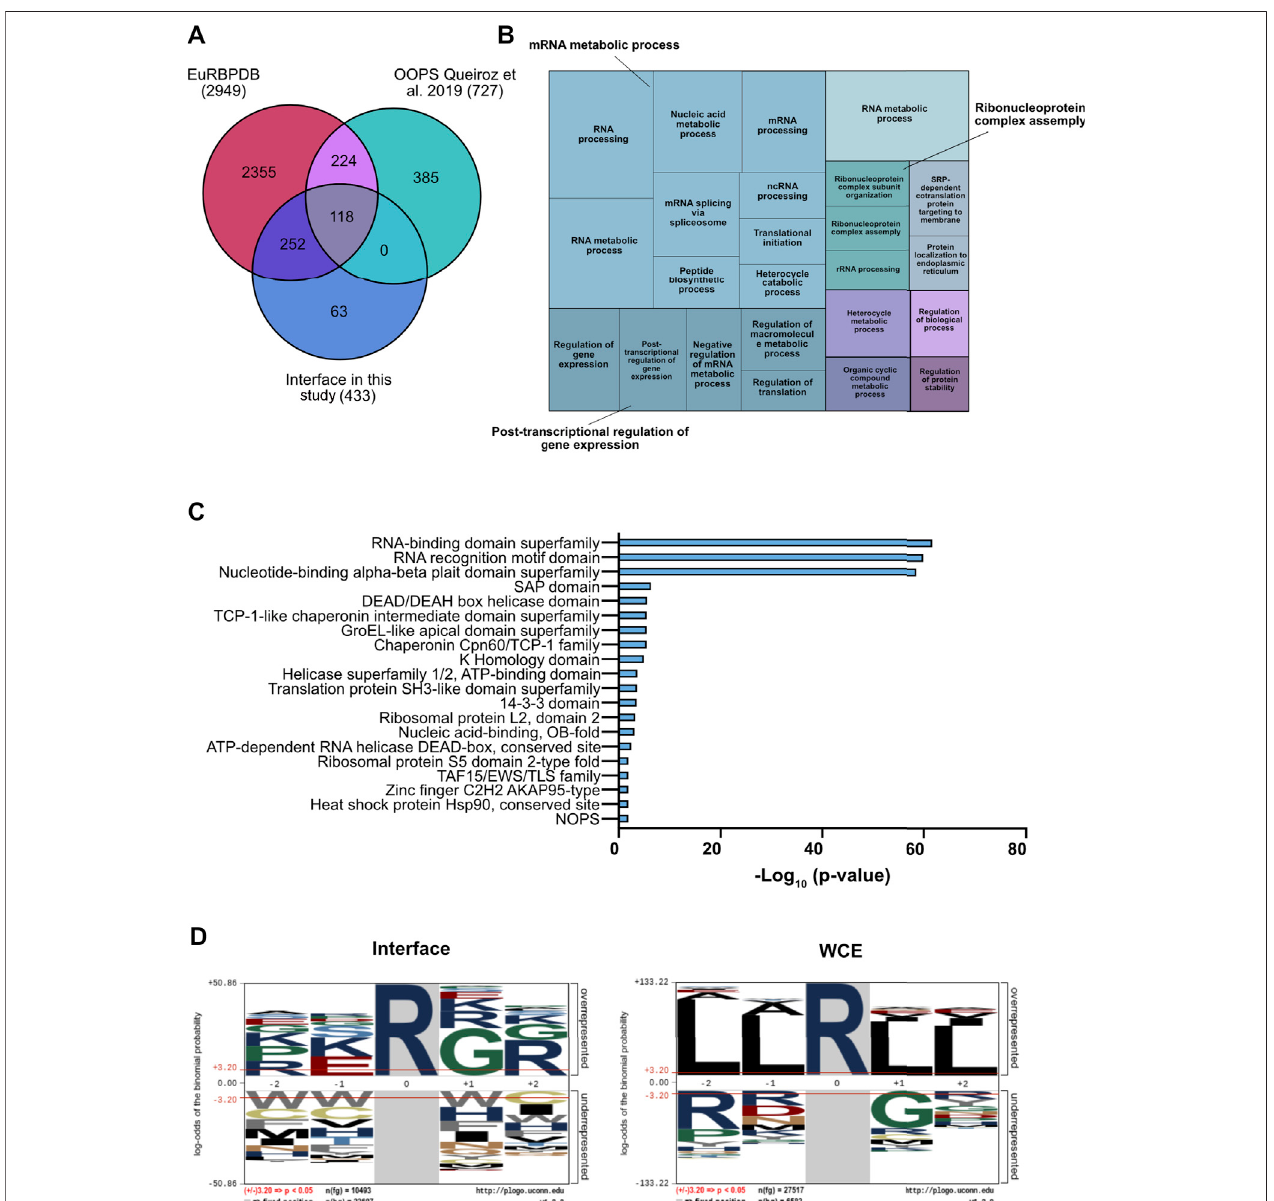
FIGURE 2 | Functional characterization of the interface fraction upon OOPS. (A) Comparative validation of RBPs enrichment in the interface fraction. Comparative analysis was performed against the Eukaryotic RNA Binding Proteins Database (EuRBPDB) and the RBPs identi fi ed in (Queiroz et al., 2019): 370 out the 433 proteins identi fi edwithinthe interfacefraction(85.5%)showed overlap withtheotherdatasets. (B) Treemaprepresentation oftheGOenriched terms intheinterface fraction.GO analysisperformedbyGOrillaandREVIGOindicatesthemostenrichedGOtermsintheinterfaceproteins. (C) Domainenrichmentanalysisoftheinterfaceproteins. Analysis was performed by STRING database on the list of the interface proteins (D) Over representation analysis of the R-centered sequences. The analysis was performed with the pLogo software, comparing interface and WCE proteins.